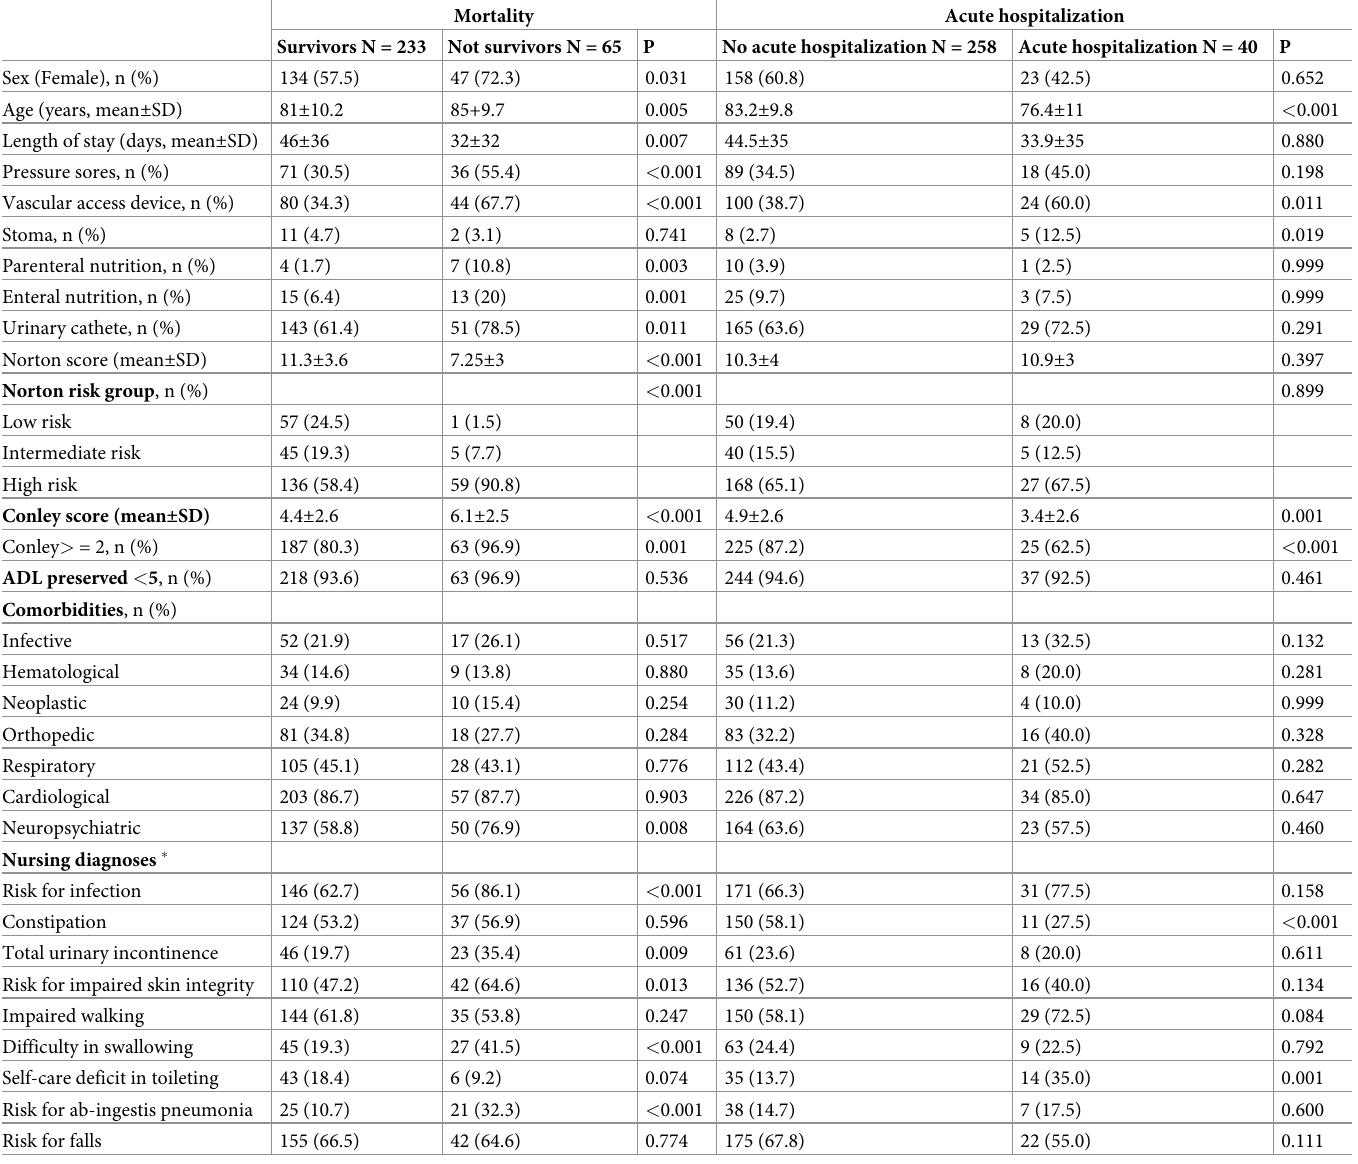
Table 2. Patients’ characteristics in accordance with outcomes (mortality and acute hospitalization during CH stay). Mortality Acute hospitalization Survivors N = 233 Not survivors N = 65 P No acute hospitalization N = 258 Acute hospitalization N = 40